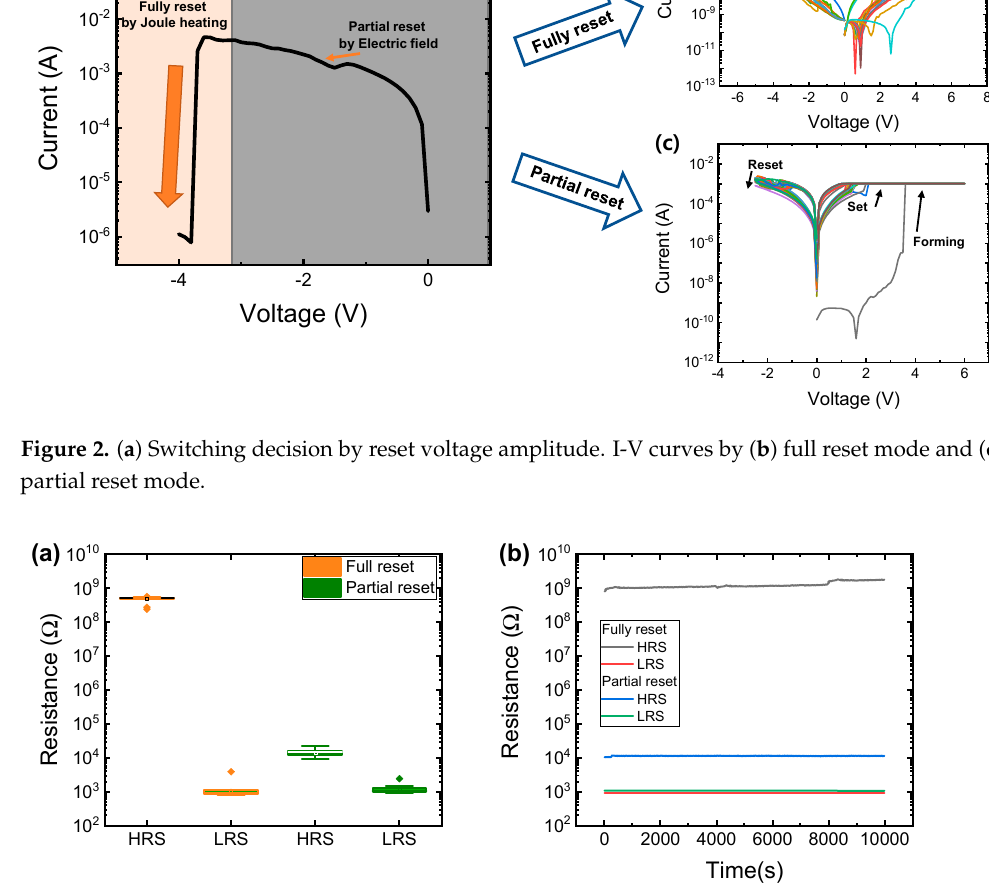
Figure 4. ( a ) Transient characteristics and ( b ) current part is expanded by set pulses. ( c ) Transient characteristics and ( d ) current part is expanded by reset pulses.